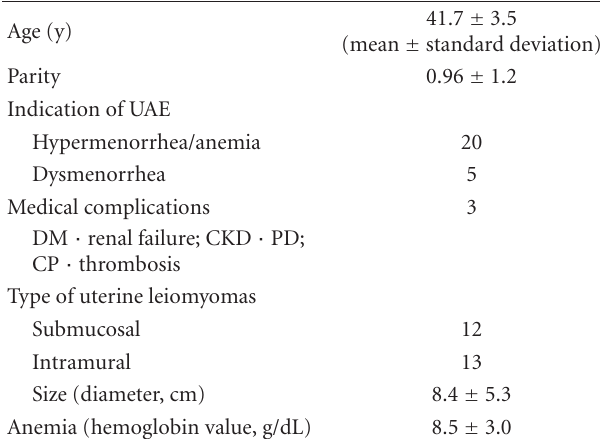
Table 1: Patient characteristics ( n = 25).